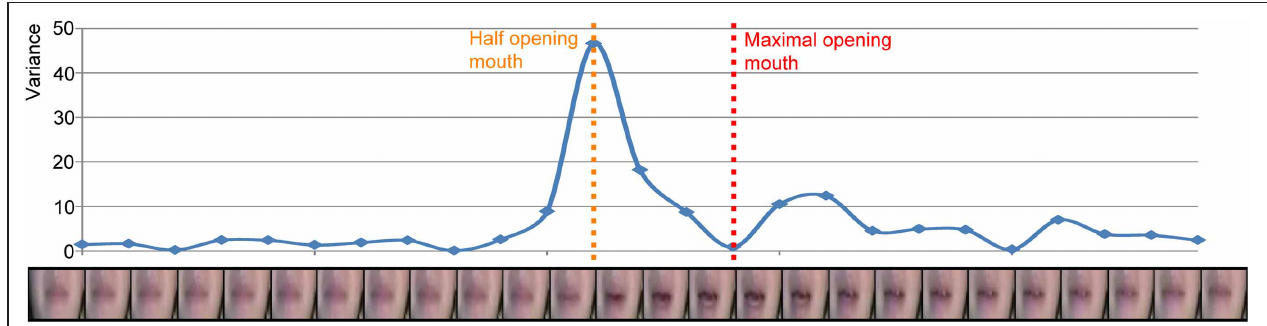
FIGURE 1 | Example of the envelope of the velocity of the mouth movement of visual /pa/. Each dot represents the variance over all pixels of the mean RGB difference for two adjacent frames (the frame left and